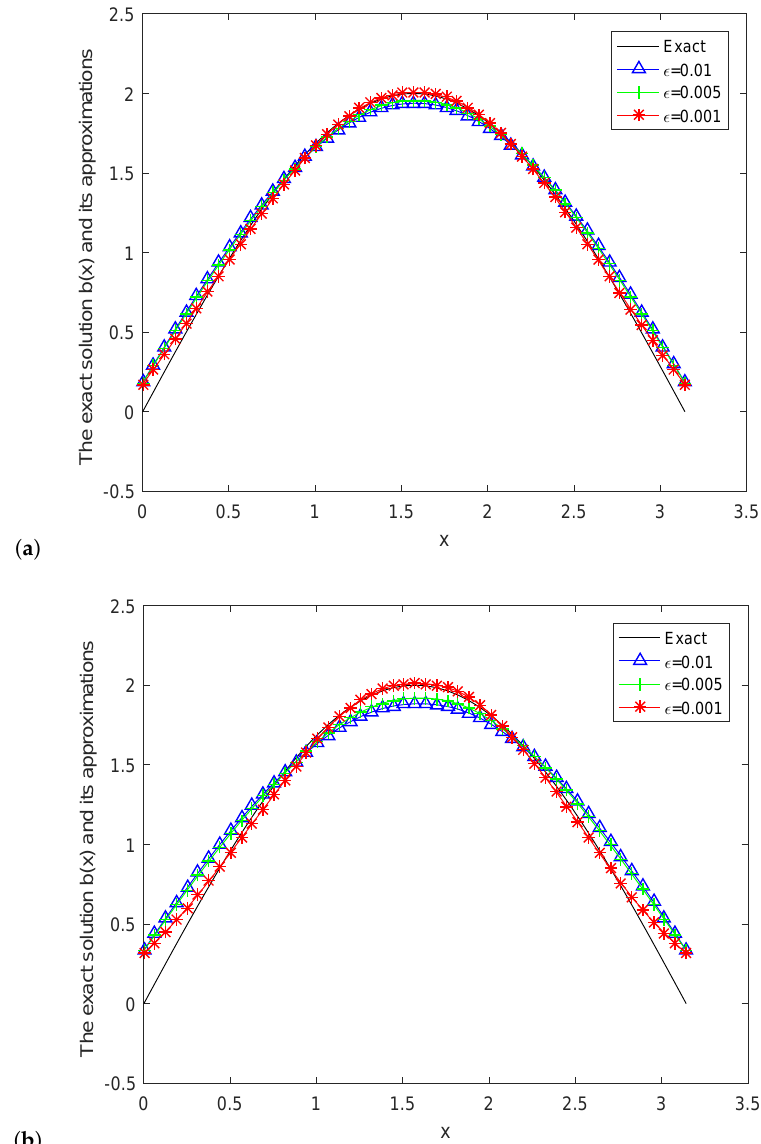
( x ) for Instance 4: ( a ) α = 1.2, ( b ) N 2